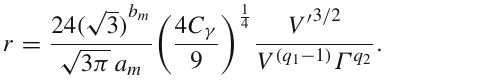
Fig. 4 The ratio of the temperature to the Hubble parameter during the inflationary period of the chameleon field driven warm inflation model in the weak dissipative regime versus the number of e-folds for different values of ( n , m ) . As one can see from the plots during inflation the temperature is larger than the Hubble parameter, and the condition T > H is satisfied